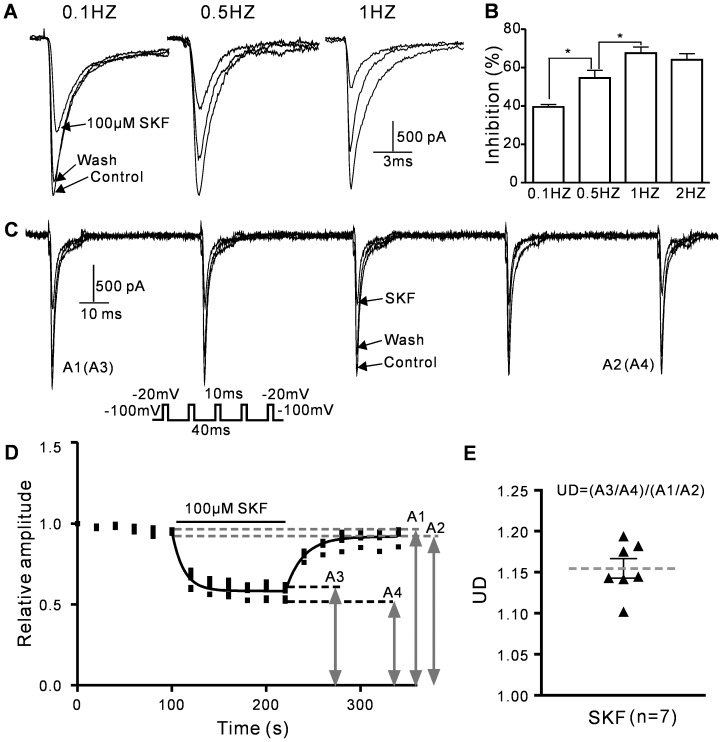
Frequency- and use-dependent inhibitory effect of (+)-SKF 10047 on I
Na.A, Sample current traces at 0.1, 0.5 and 1 Hz pulse frequencies were obtained in the presence and absence of 100 µM (+)-SKF-10047. B, SKF inhibition of I
Na increased with increased pulse frequency. *, P<0.05 compared to 0.1 Hz. C, Sample NaV1.2 current traces for 5 Hz-train depolarizations from −100 to −20 mV were obtained in the presence and absence of 100 µM (+)-SKF-10047. D, The time course of the peak amplitude changes during the train pulses. Use-dependence (UD) = (A3/A4)/(A1/A2). E, The individual UD data points (black triangles) and the UD means±SEM (gray dashed line) under the 5-Hz train pulse condition. The UD ranged from 1.10 to 1.19.